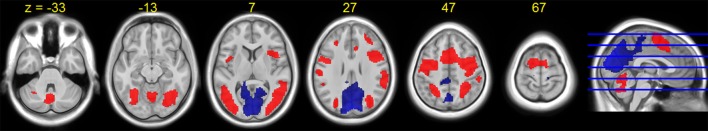
HDBR group T-statistic maps for brain activation (red) and deactivation (blue) for dual task at baseline (session 2). Thresholded at abs (T) > 3.218.